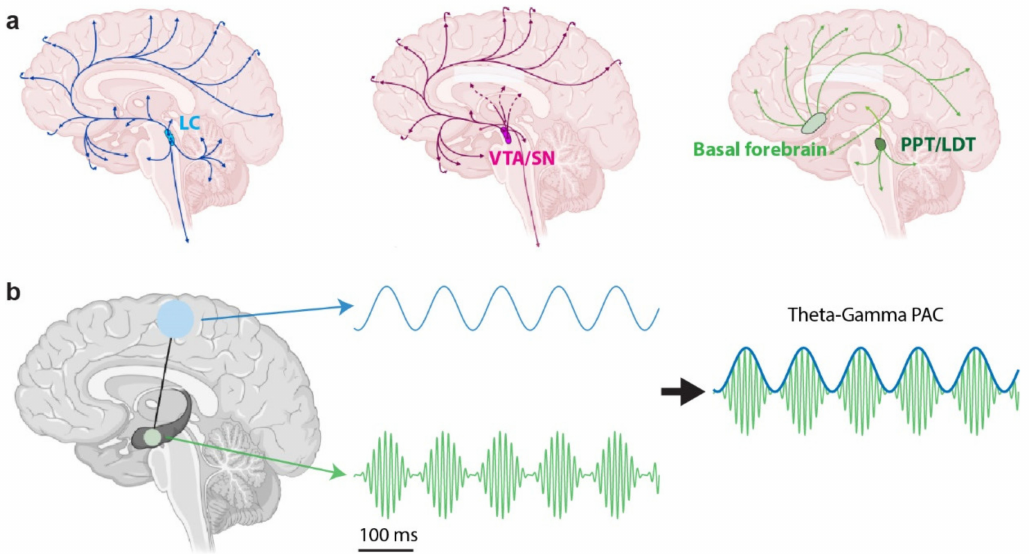
Figure 1. Anatomical representations of each neuromodulatory system and CFC visualization: ( a ) Anatomical locations and projections of the three neuromodulatory systems: the noradrenergic system ( left ), dopaminergic system ( middle ), and cholinergic system ( right ). ( b ) A cartoon illustrating theta–gamma phase–amplitude coupling